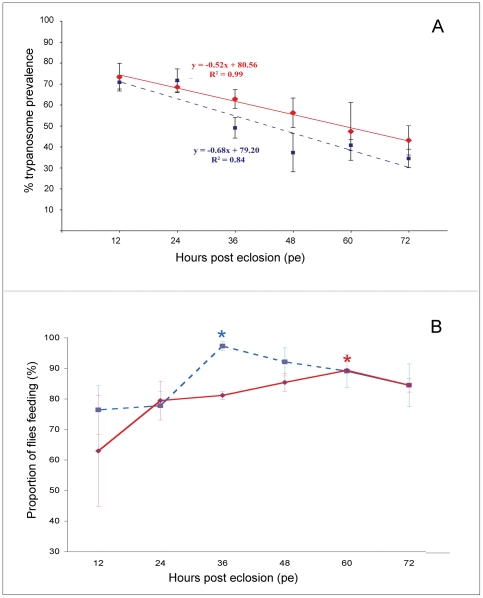
The age-prevalence of teneral G. m. morsitans midgut infections.Male (broken blue line) and female (solid red line) infection data are depicted. Flies were collected every 12 h over three days and infected with a first bloodmeal containing T. b. brucei TSW196 BSF. Panel A graphs the percentage of immature midgut infections (y-axis) versus the post emergence age of teneral tsetse (x-axis). Regression analyses are shown as equations. Panel B compares the percentage of flies that accepted the first bloodmeal (y-axis) against fly age p.e. (x-axis). Asterisks mark the age at which male (blue) and female (red) have the highest probabilities of feeding post emergence. Flies were collected from three independent experiments.